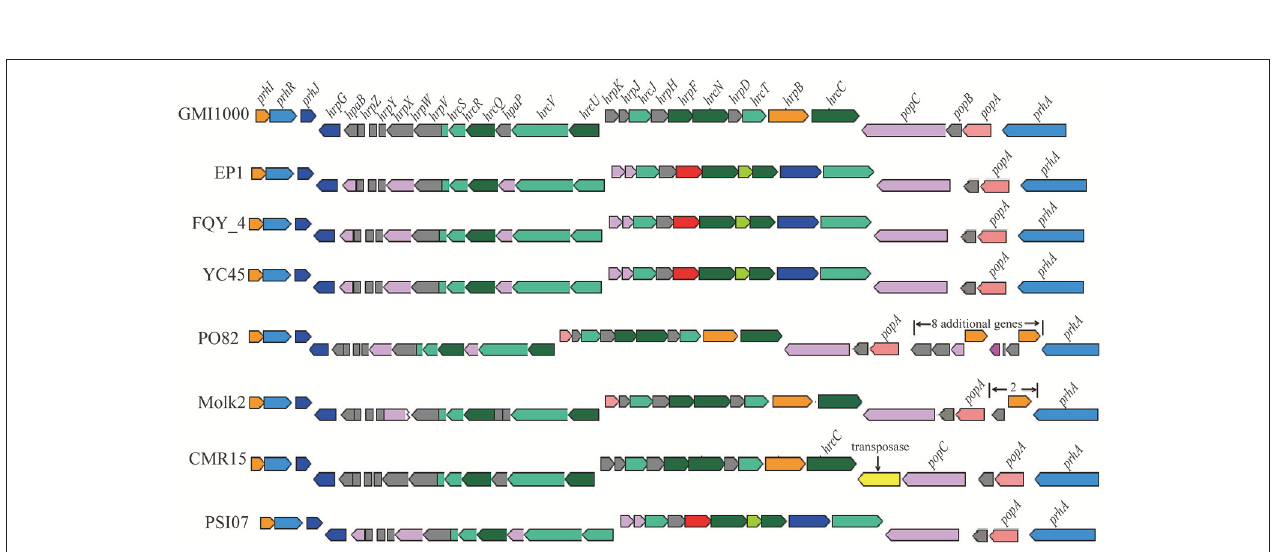
FIGURE 8 | Genetic organization of hrp clusters in R. solanacearum species.